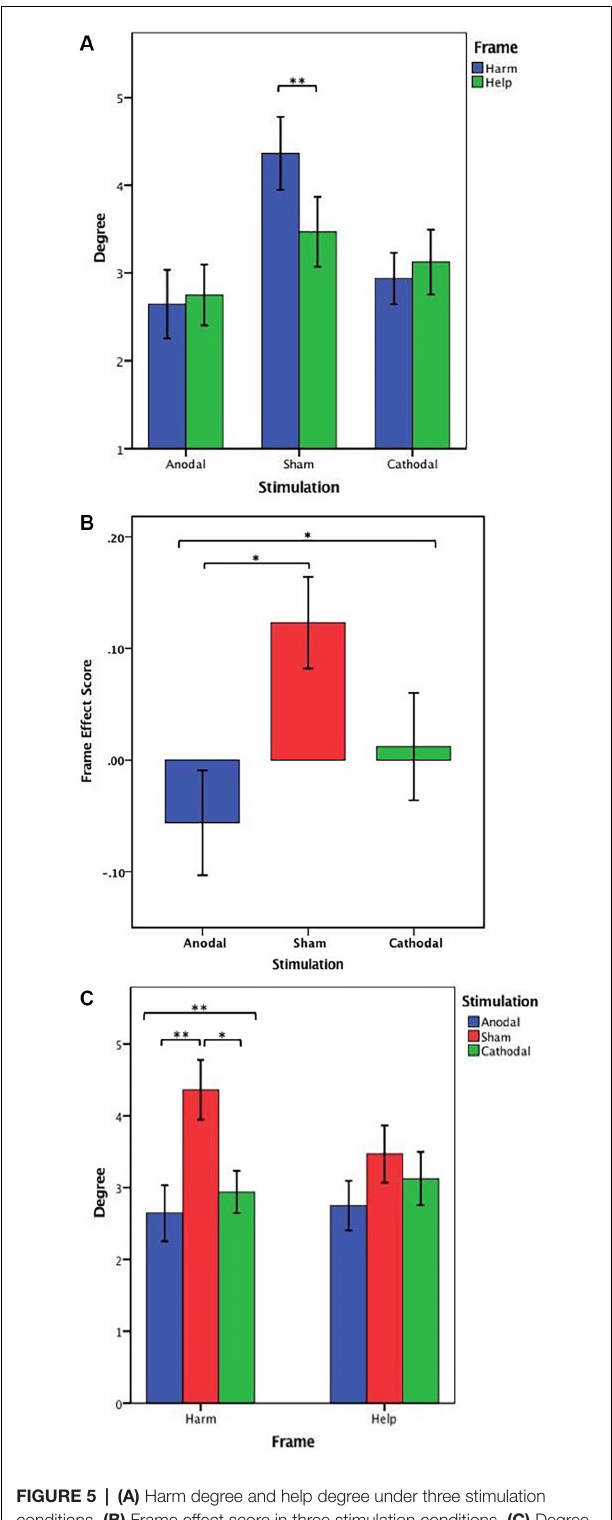
FIGURE 5 | (A) Harm degree and help degree under three stimulation conditions. (B) Frame effect score in three stimulation conditions. (C) Degree in the harm frame and the help frame across three stimulation conditions. Error bar represents standard error. Asterisks indicate a statistically significant difference between the harm degree and the help